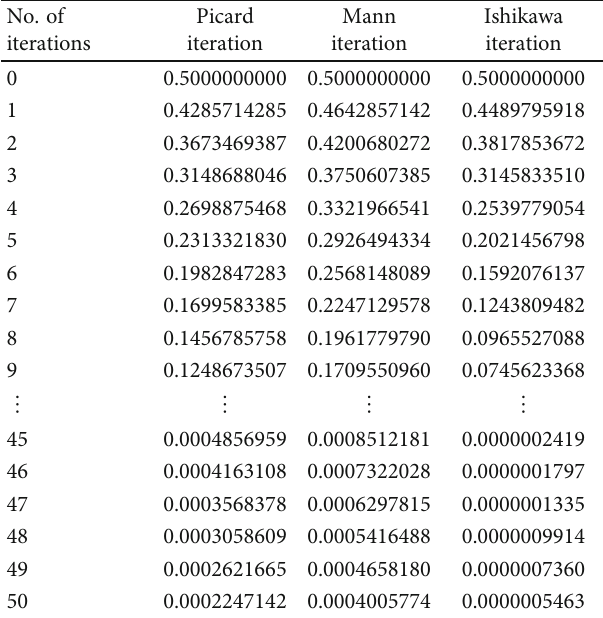
Table 1: Convergence behavior of the three iterative processes to the fi xed